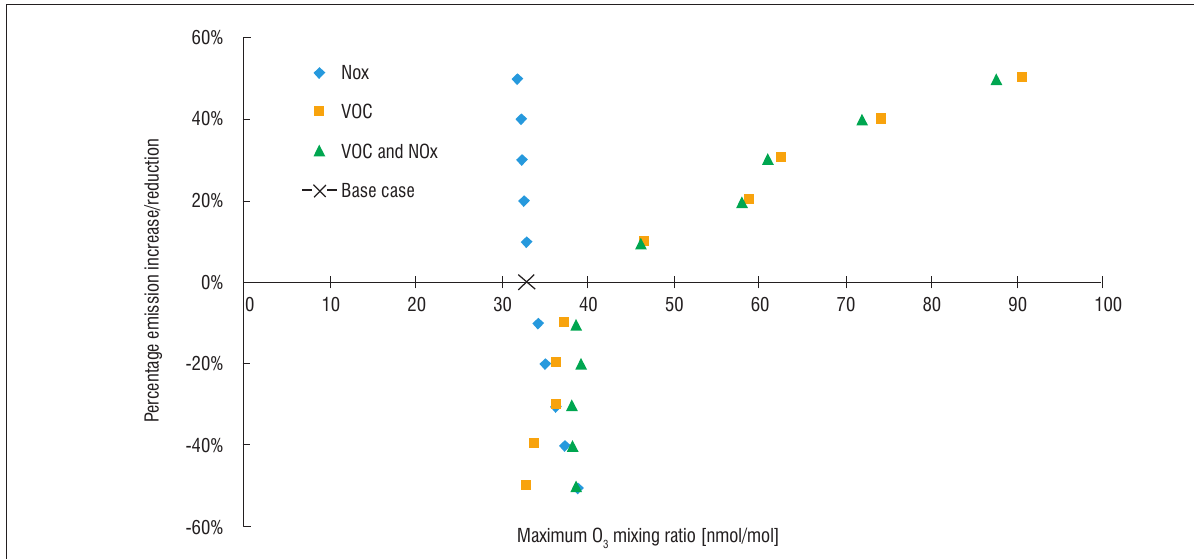
mixing ratios associated with each percentage increase/decrease of NOx and VOCs (volatile organic compounds) Figure 6: The change in the maximum O 3 emissions.